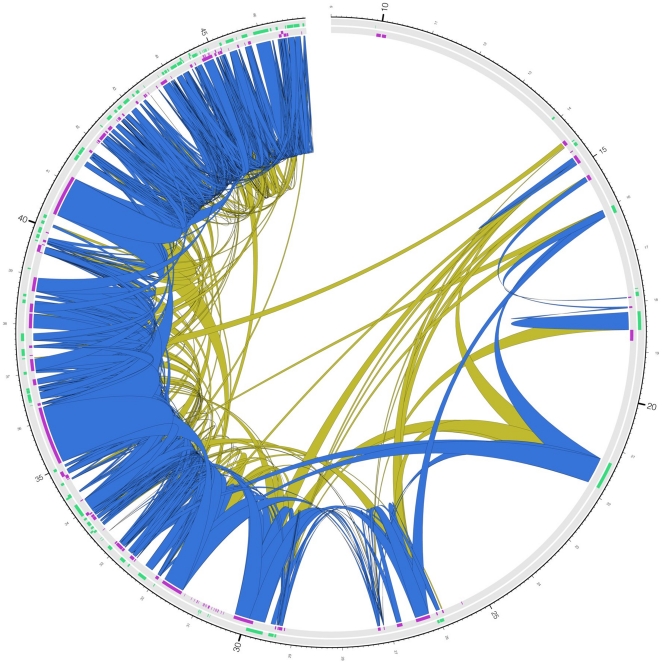
Reciprocal gene/gene connections supported by 5C on chromosome 21.The 638 reciprocal gene/gene connections on chromosome 21 are represented as blue inner links if they are supported by 5C, and as yellow inner links otherwise.